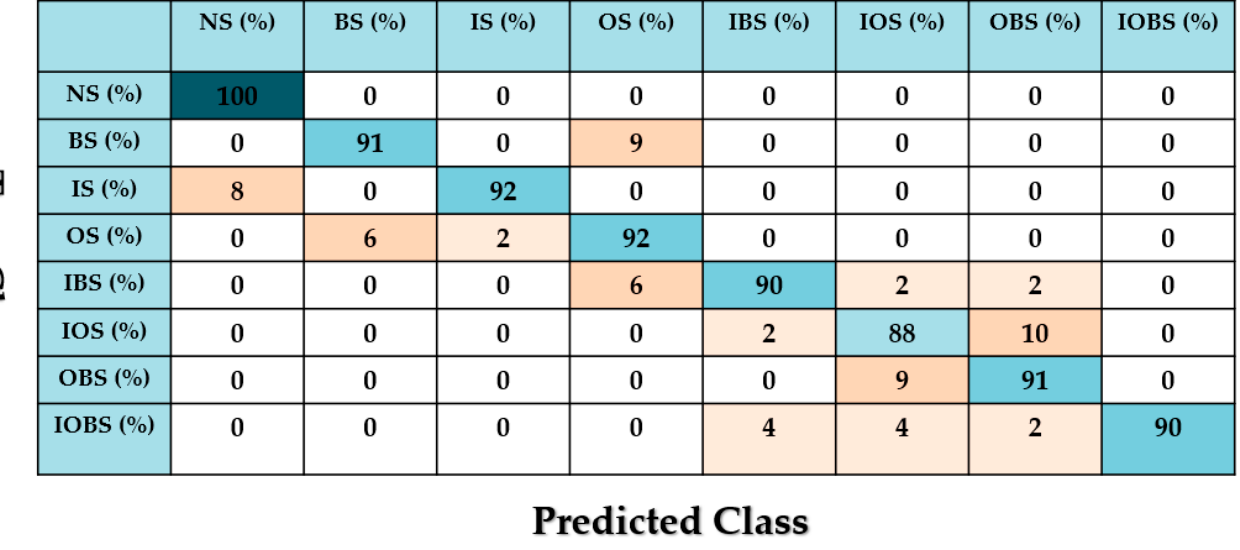
Figure 13. The average of anomaly diagnosis using the combination of high-order sliding digital twin and SVM.